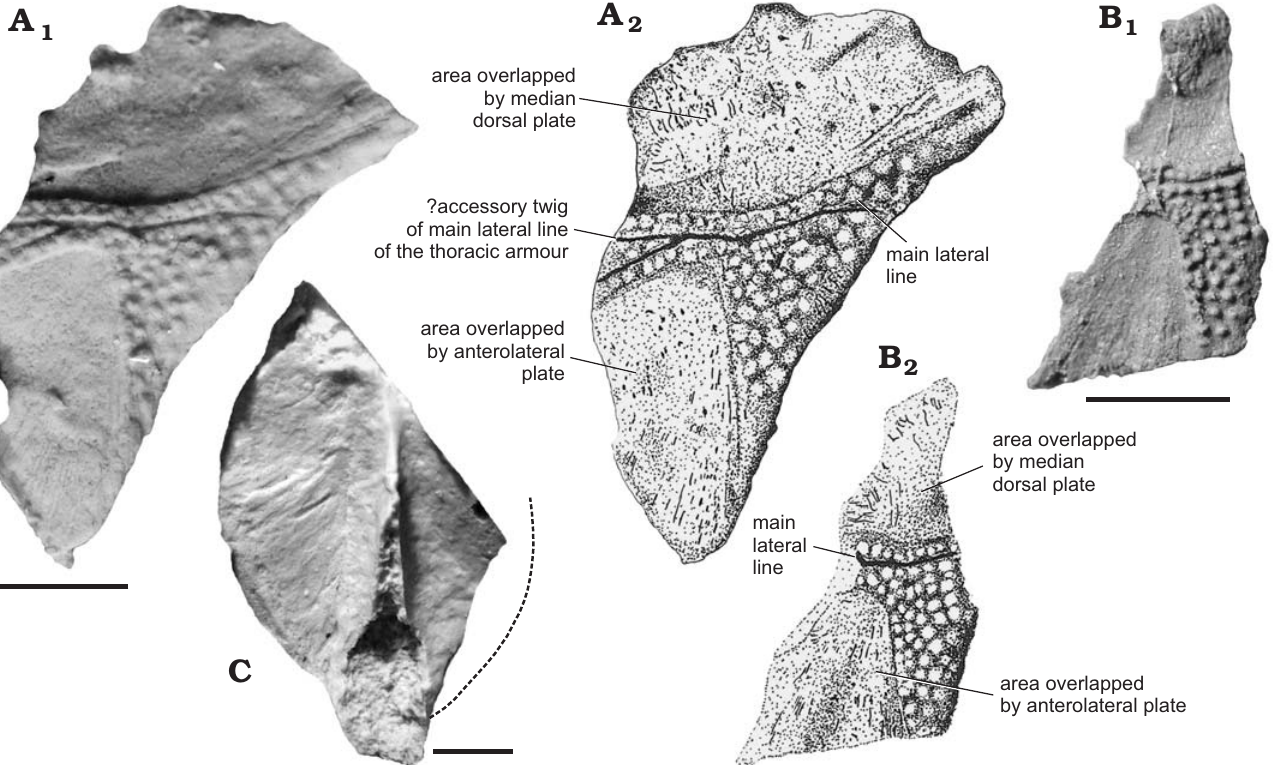
Fig. 5. Arthrodiran placoderm Brachythoraci indet. from Lower Devonian (Emsian) of Pod ł azie Hill, Holy Cross Mountains, Poland. A . Muz PGI 1733.II.114, print of subcomplete left anterior dorsolateral plate (A 1 , photograph; A 2 , “negative drawing”). B . Muz PGI 1733II.107, countreprint subcomplete right anterior dorsolateral plate (B 1 , photograph; B 2 , drawing). C . Muz PGI 1733.II.225, ventral side of an incomplete median dorsal plate. Scale bars 10